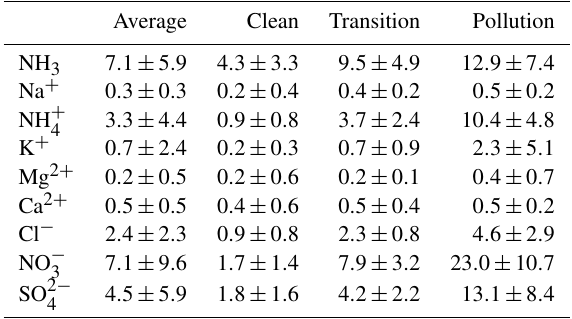
Table 2. Concentrations (µgm − 3 ) of ammonia and inorganic ions of PM 2 . 5 measured by IGAC during the